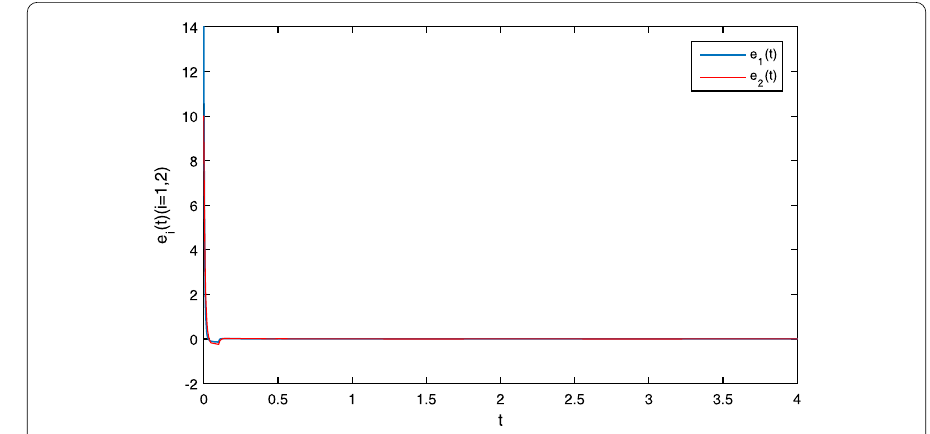
Figure 5 The synchronization errors e i ( i = 1,2) state with β = –3